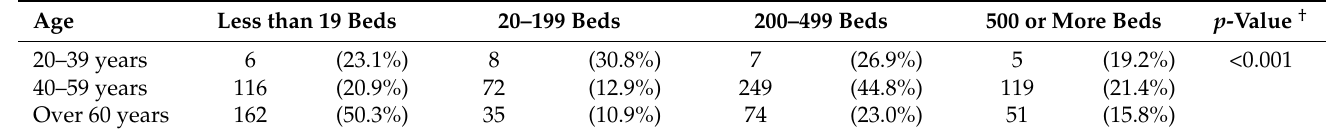
Table 4. Age of the respondents and the number of hospital beds in their employing medical